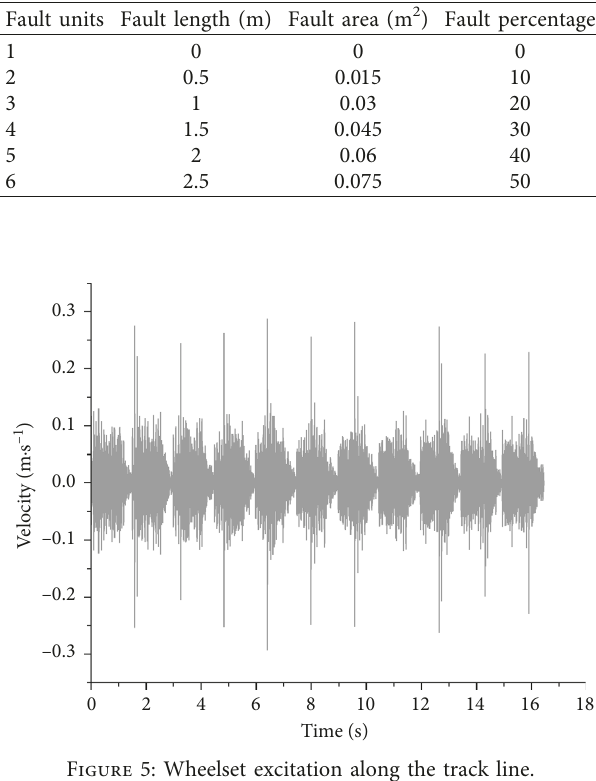
Figure 5: Wheelset excitation along the track line.